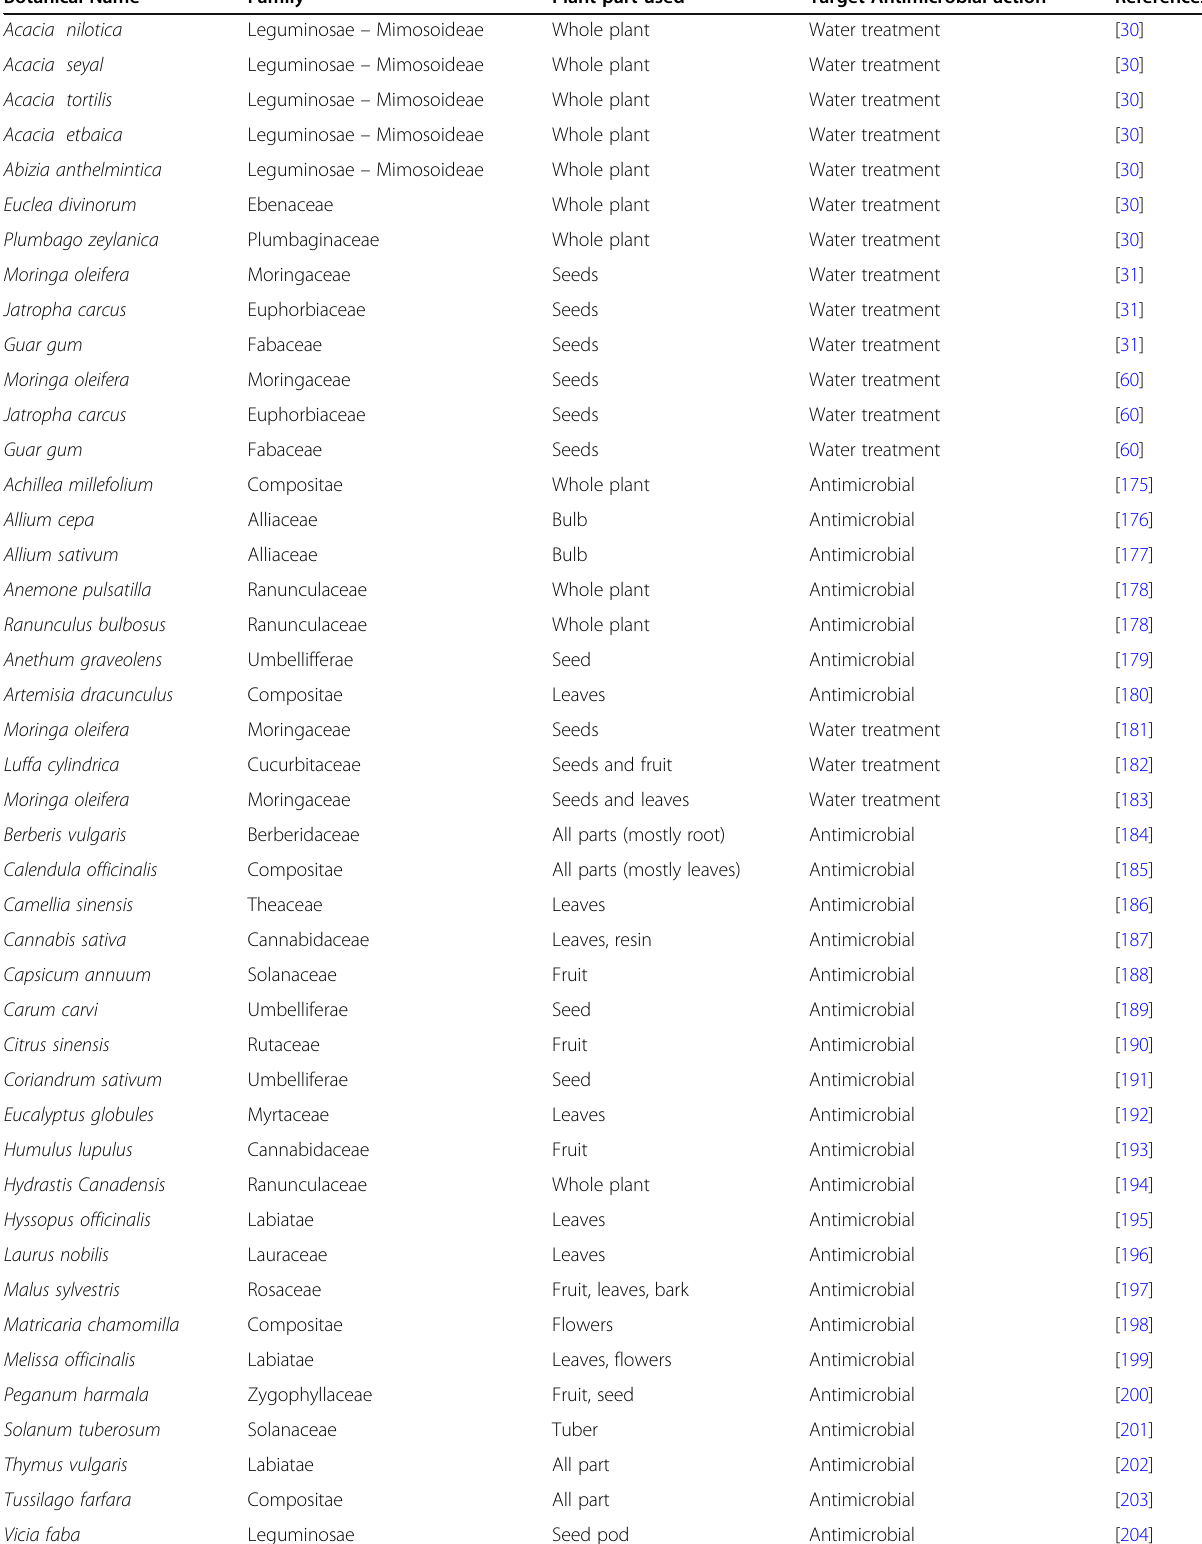
Table 6 Reported uses of some plants Botanical